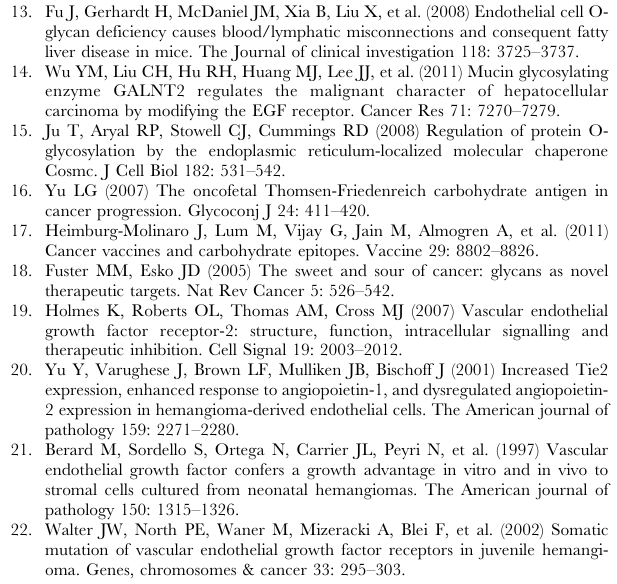
Figure S1 Immunohistochemistry of COSMC in normal blood vessels. The arrows show relatively weak COSMC